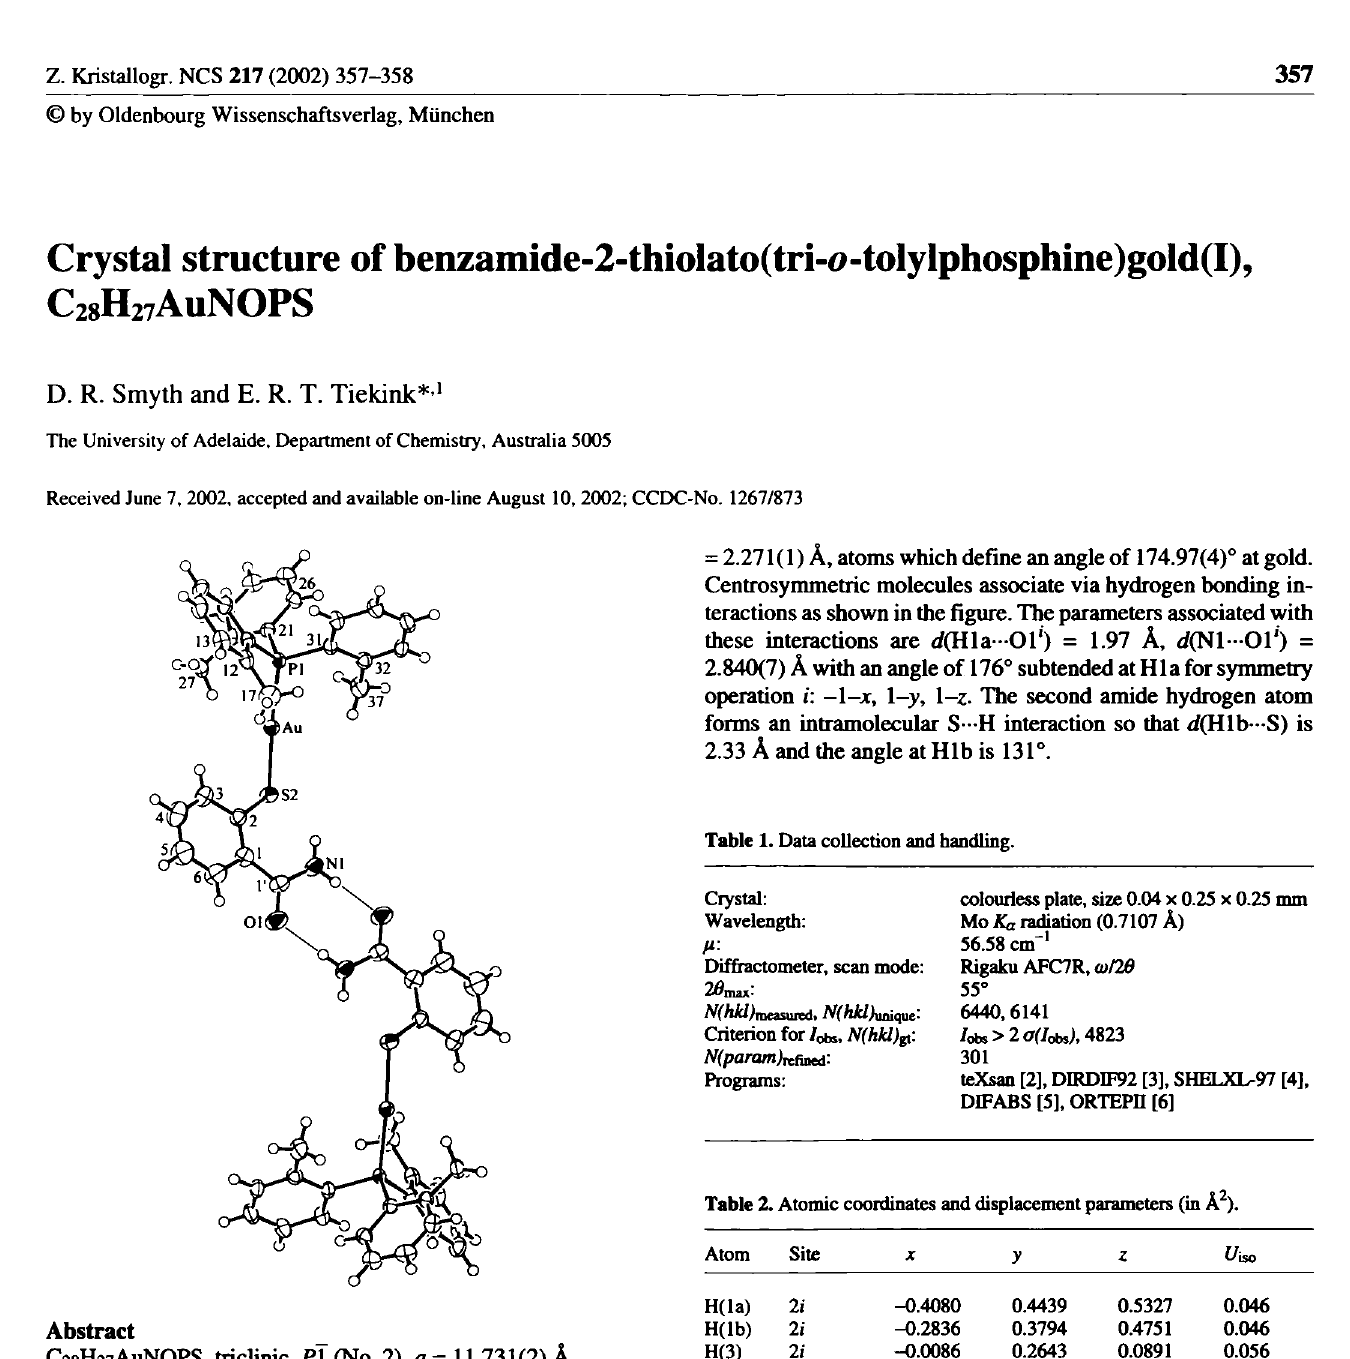
Table 2. Atomic coordinates and displacement parameters (in Â 2